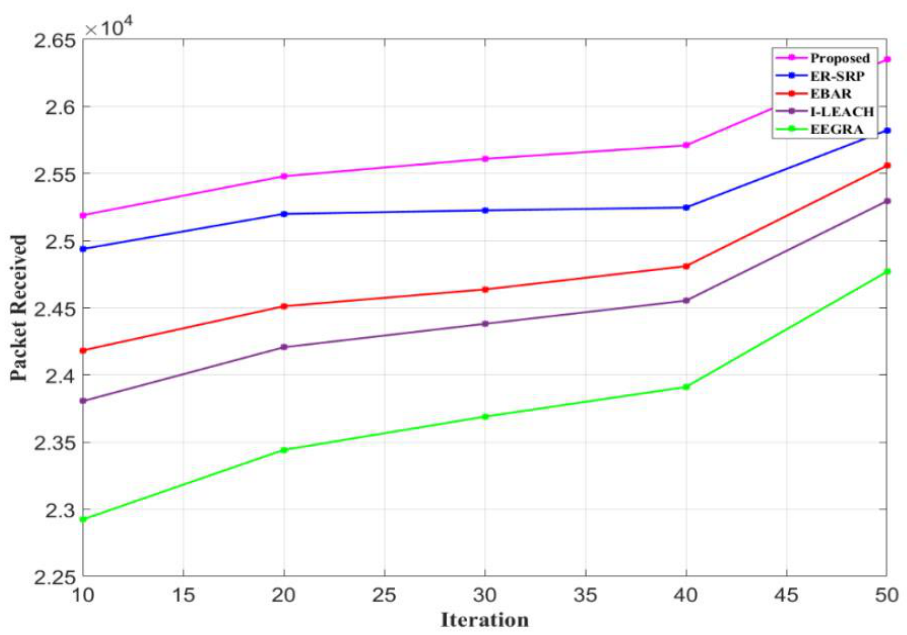
Figure 13. Comparison of packet loss.